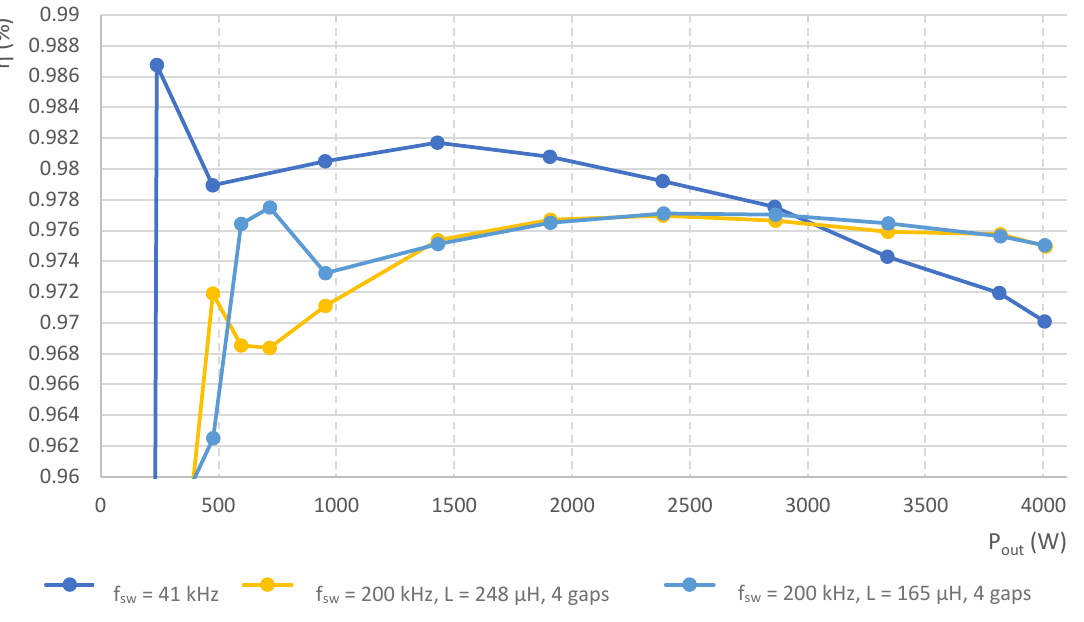
Figure 22. Comparison of the efficiency performance in dependency on the output power of converter for original inductor and inductors with the distributed air gap.